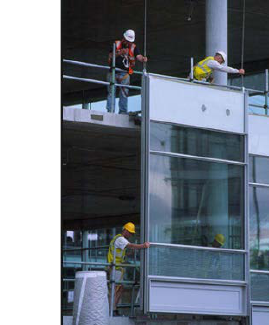
Fig. 1 Installation of traditional non-integrated frame unitised panels for curtain wall